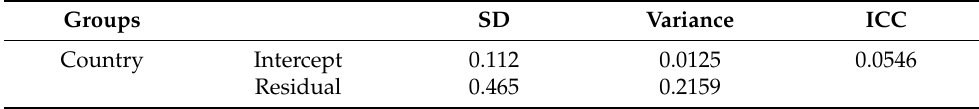
Table 12. Sexting under pressure: estimates of random